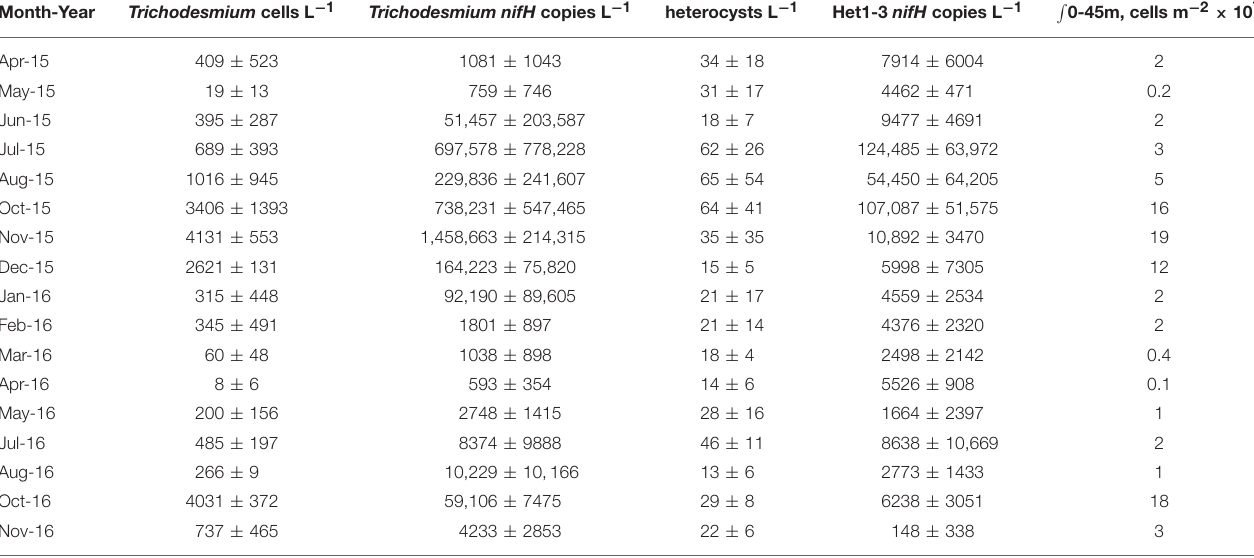
TABLE 1 | Depth-averaged mean and standard deviation of large diazotroph abundance in the upper 45m as determined via microscopy and qPCR with the depth integrated ( R ) abundances of the summed organism classes as determined from microscopy based cell